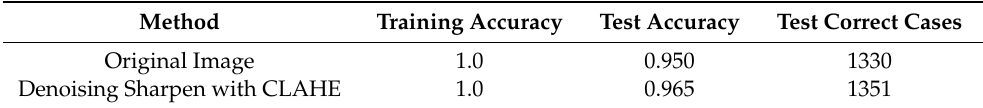
Table 7. Effect of the proposed method on RSSCN7 dataset.